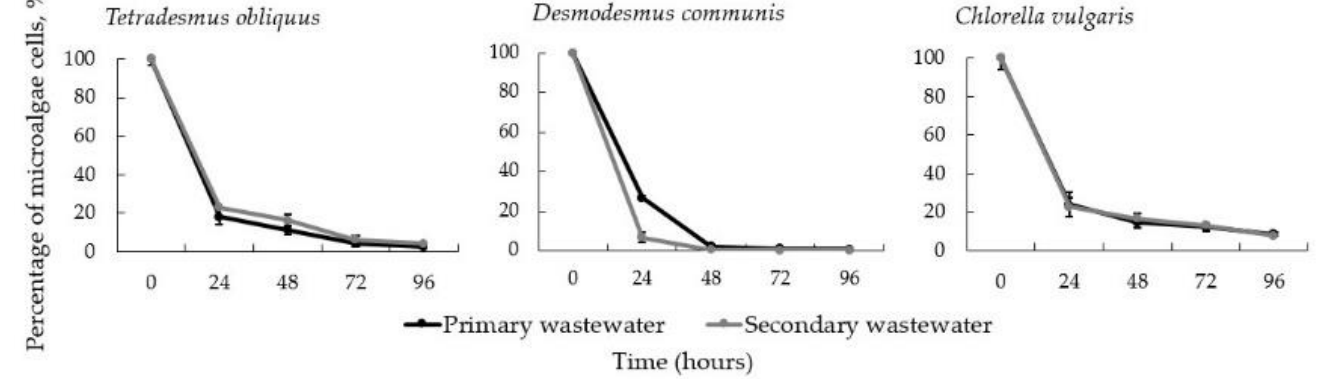
Figure 7. Percentage of D. communis , T. obliquus and C. vulgaris in primary and secondary wastewater after bio-flocculation with I. lacteus . Standard deviation represents the average from three replicates.